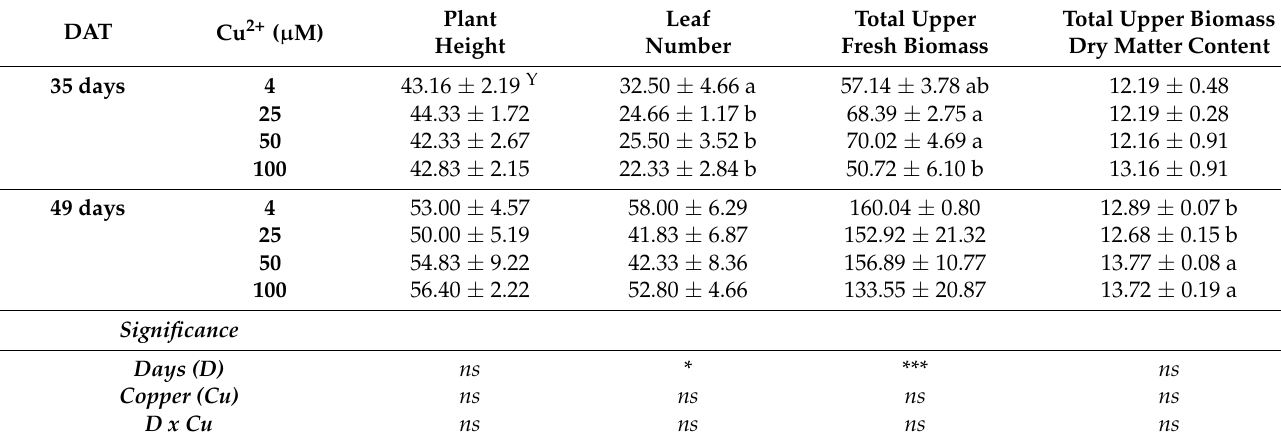
and dry matter content (Table 1). Copper concentration in the nutrient solution affected pelargonium growth parameters (Table 1). Plants grown with ≥ 25 µ M Cu in the nutrient solution produced lower number of leaves at 35 DAT (days after transplanting), but this effect did not persist at 49 DAT. Total upper fresh biomass (including leaves, petioles and stems) decreased at the highest Cu (100 µ M Cu) levels compared with the plants grown at 25 µ M or 50 µ M Cu after 35 DAT. Dry matter content at 49 DAT increased in plants grown in ≥ 50 µ M Cu compared to 25 µ M Cu and control treatment. Table 1. Effect of increasing copper (Cu) concentration (4–25–50–100 µ M Cu +2 ) in the nutrient solution and sampling date after transplanting (DAT, 35 days and 49 days) on plant height (cm), leaf number, total upper fresh biomass (g plant − 1 ), and biomass dry matter content (%) in pelargonium plants grown hydroponically in